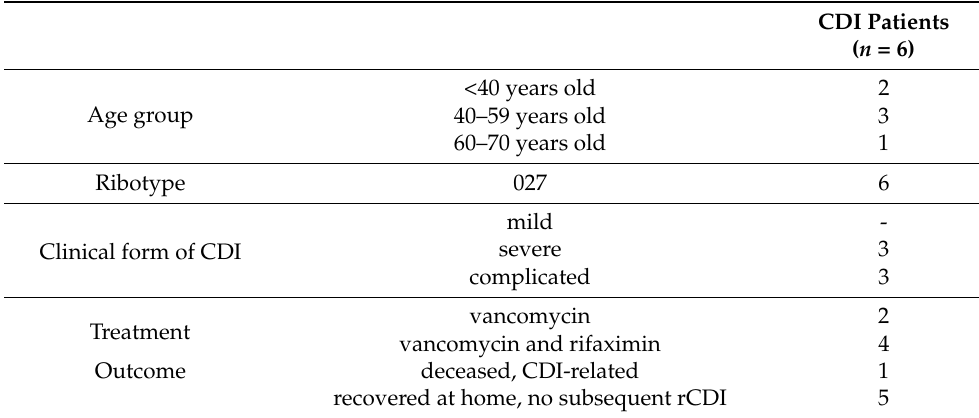
Table 3. CDI ribotype, clinical features, treatment, and outcome.